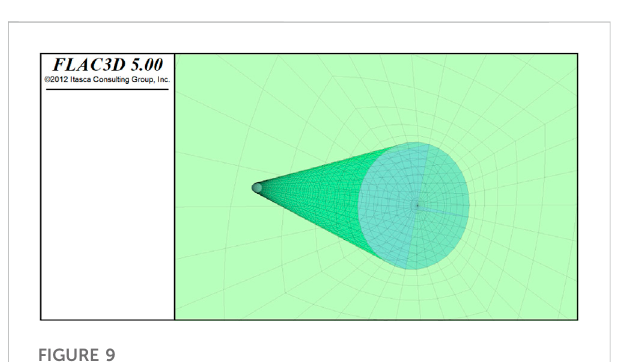
FIGURE 9 Numerical simulation model of the circular section